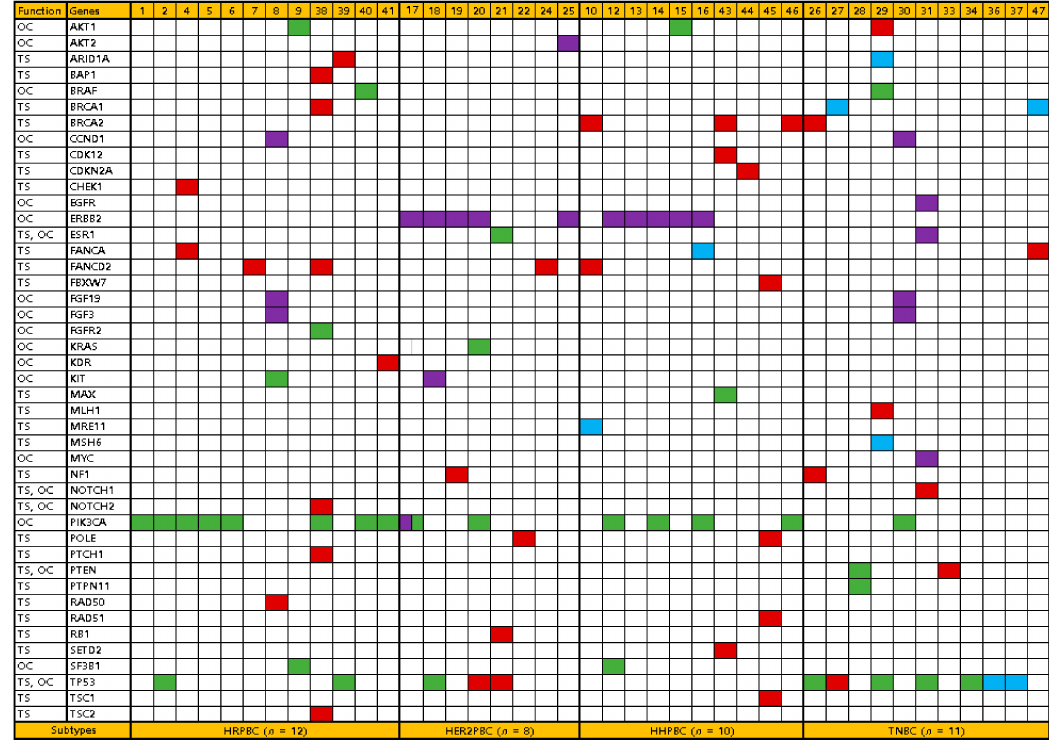
Figure 2. Distribution of somatic alteration profiles based on breast cancer subtypes in 41 patients with breast cancer. Each patient is depicted on the x-axis, and the genes are indicated on the y-axis. Green, missense mutation; red, nonsense mutation; blue, frameshift mutation; violet, amplification. HRPBC, hormone receptor-positive breast cancer; HER2PBC, hormone receptor-negative HER2-positive breast cancer; HHPBC, hormone receptor-positive and HER2-positive breast cancer; TNBC, triple-negative breast cancer. OC, oncogene; TS, tumor